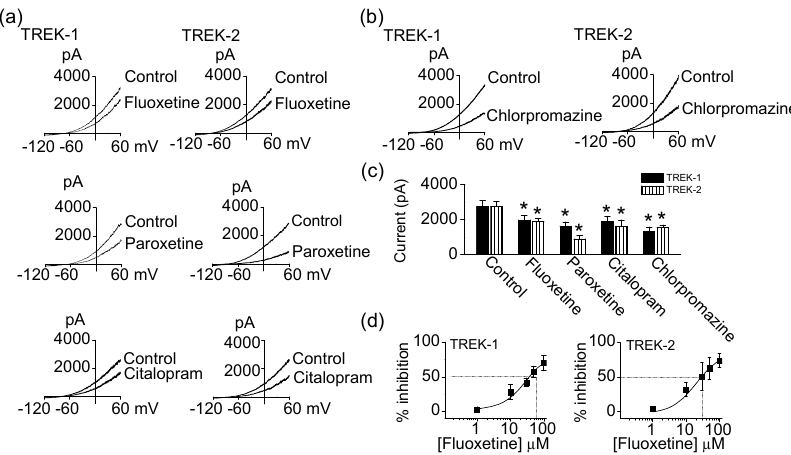
Figure 1. Effect of antidepressants and antipsychotics on TWIK-related K + (TREK) channels. ( a ) Inhibition of TREK currents by fluoxetine, paroxetine, and citalopram. Whole-cell currents were recorded from HEK-293A cells expressing TREK-1 and TREK-2 before and after application of antidepressants. Cell membrane potential was held at − 80 mV, and ramp pulses were applied from − 120 mV to +60 mV. Pipette solution contained 150 mM KCl and bath solution contained 5 mM KCl and 135 mM NaCl; ( b ) Inhibition of TREK currents by chlorpromazine. Same protocol for recording of whole-cell currents as in a; ( c ) Summary of effect of fluoxetine (TREK-1, n = 10; TREK-2, n = 6), paroxetine (TREK-1, n = 10; TREK-2, n = 7), citalopram (TREK-1, n = 10; TREK-2, n = 7), and chlorpromazine (TREK-1, n = 4; TREK-2, n = 16) on TREK currents. Each bar is the mean ± standard deviation (SD ) of five experiments. Asterisk (*) indicates a significant difference against the control without application of fluoxetine, paroxetine, citalopram, or chlorpromazine ( p < 0.05); ( d ) Dose-dependent effect of fluoxetine on TREK-1 ( n = 8) and TREK-2 ( n = 4) current. The inhibition of TREK current by increasing concentrations of fluoxetine (1 to 100 μ M).